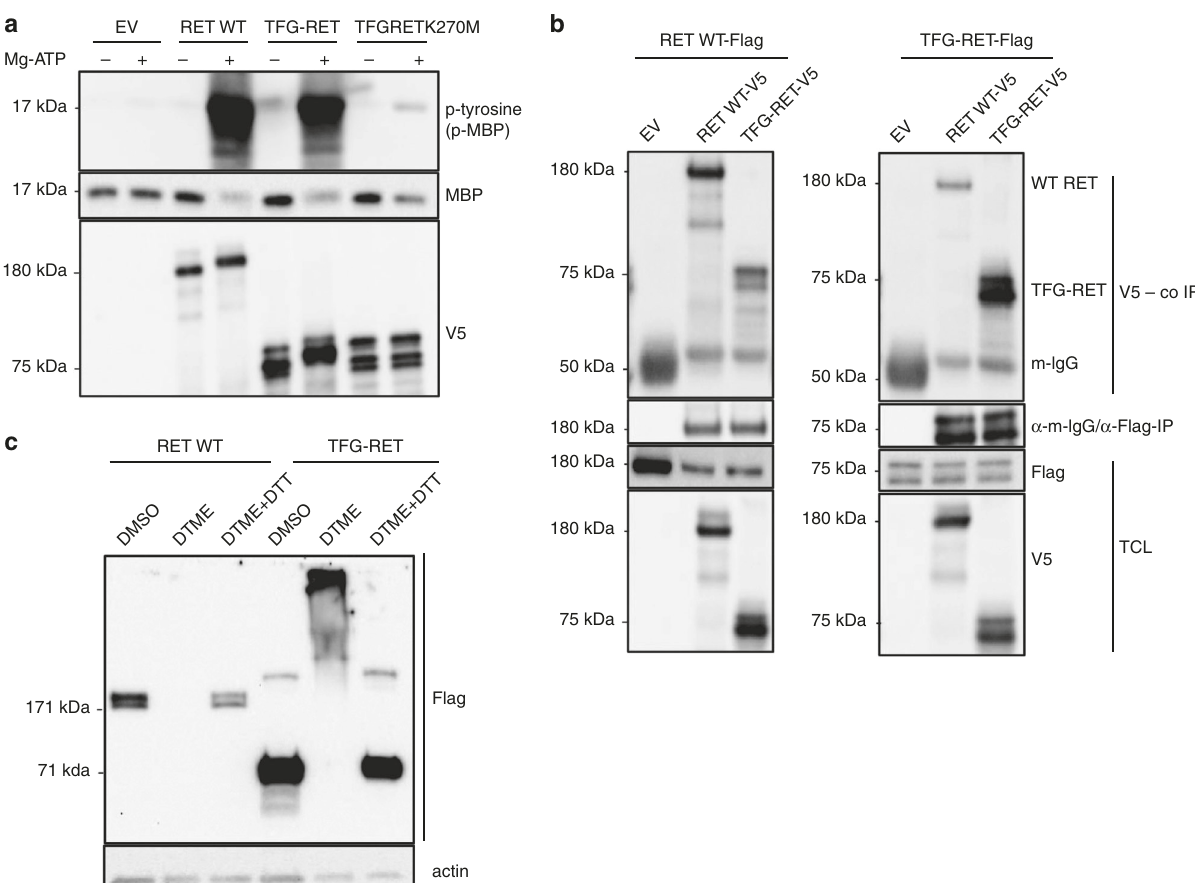
Fig. 3 TFG-RET exhibits kinase activity and forms oligomeric complexes. a HeLa cells were transiently transfected with V5-tagged wild-type RET, TFG- RET and kinase dead TFG-RET K270M along with empty vector. After 48 h cells were lysed and subjected to immunoprecipitation using anti-V5 antibody. After subsequent washes, the immunoprecipitated proteins were used for in vitro kinase assay, as described in Methods. TFG-RET phosphorylated MBP, thus exhibiting kinase activity like wild-type RET kinase. This kinase activity was abrogated in the TFG-RET kinase dead mutant (p, phosphorylated). Shown are representative data from at least three independent experiments. b HeLa cells were co-transfected with FLAG-tagged and V5-tagged wild-type RET and TFG-RET as indicated, followed by anti-FLAG immunoprecipitation after 48 h. Lysates were analyzed by western blotting (TCL, total cell lysate). Wild-type RET (FLAG ® ) co-immunoprecipitated with wild-type RET (V5) and also with TFG-RET (V5) (left panel), similarly, TFG-RET (FLAG ® ) also co- immunoprecipitated with both wild-type RET (V5) and TFG-RET (V5). Empty vector controls were included. Shown are representative data from at least three independent experiments. c Nthy-ori 3-1 cells stably expressing wild-type RET and TFG-RET were treated with DTME and DTME + DTT. Upon chemical crosslinking with DTME, similar to wild-type RET, TFG-RET also formed high molecular weight heteromeric complexes and these complexes were disrupted upon reduction with DTT (lane 3 and 6). Shown are representative data from at least two independent